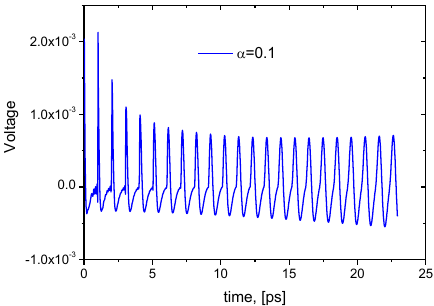
Fig. 6. The developed stage of voltage oscillations (a.u.) originating from fluctuations of density in the channel. Quite non-harmonic oscillations with slowly varying amplitude are